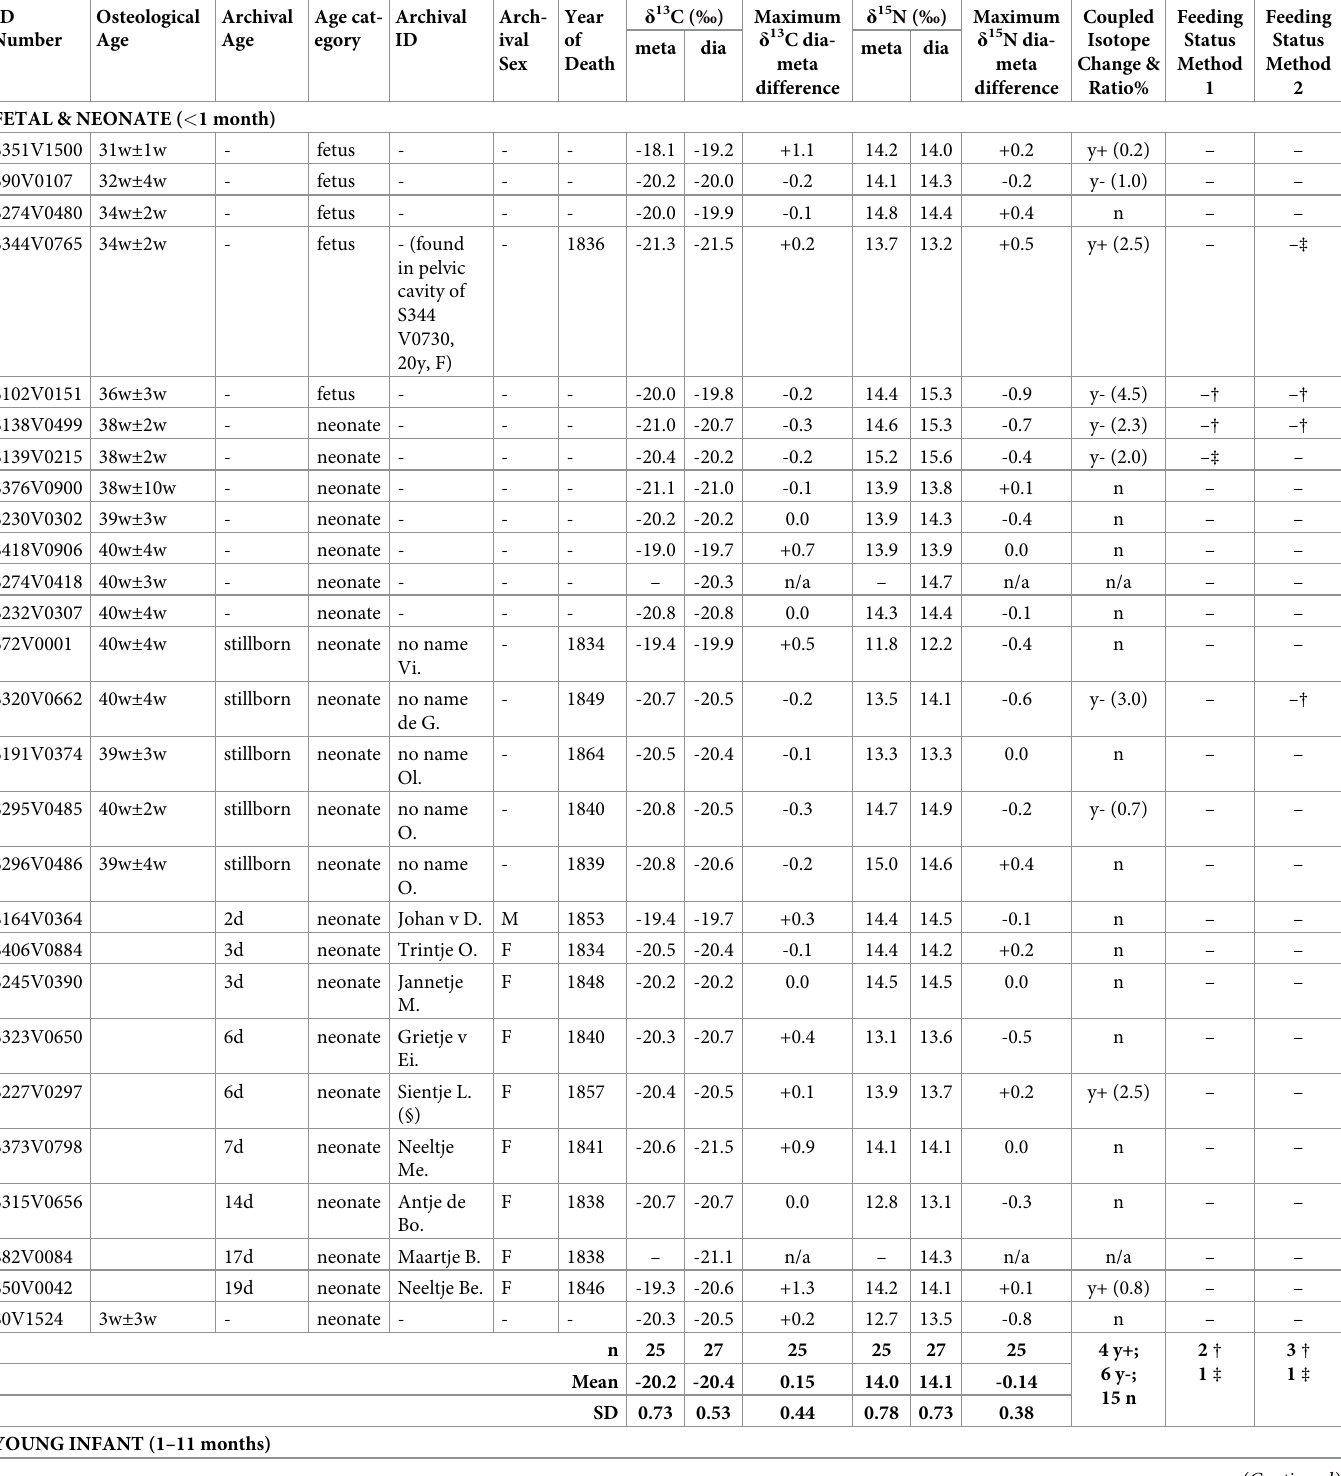
Table 3. δ 15 N and δ 13 C results for Beemster nonadults � 6 years of age with results of feeding status at death criteria. N Bf = no breastfeeding (hence no weaning); Bf = breastfeeding; W = weaning; I = indeterminate (see Figs 2 and 3). Different results between interpretive method 1 and 2 are